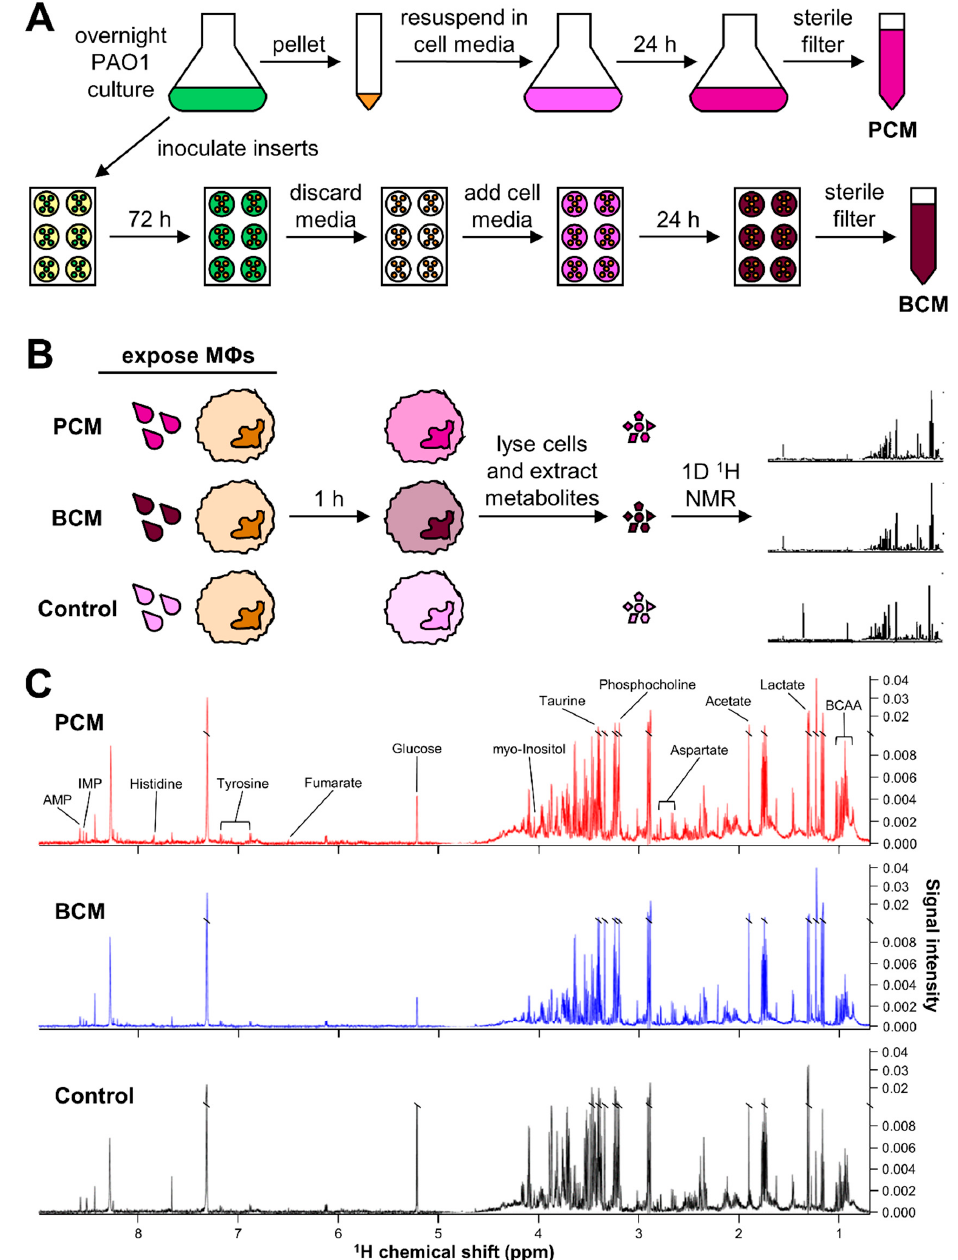
Figure 1. Overview of experimental design and 1D 1 H-NMR methods. Schematic overview of experimental approaches concerning ( A ) the generation of planktonic-conditioned media (PCM) and biofilm-conditioned media (BCM), and ( B ) the exposure of primary human monocyte-derived macrophages (M Φ s) to PCM, BCM, and control media followed by cell lysis, metabolite extraction, and 1D 1 H-NMR analysis. ( C ) Representative 1D 1 H-NMR spectra of intracellular metabolite extracts derived from primary human monocyte-derived M Φ s exposed to PCM (red), BCM (blue), and control (black) media acquired on a Bruker 600 MHz ( 1 H Larmor frequency) NMR spectrometer at Montana State University. Visually distinct metabolite signals are indicated above the NMR spectra. Abbreviations denote: AMP, adenosine monophosphate; BCAA, branched-chain amino acids; IMP, inosine